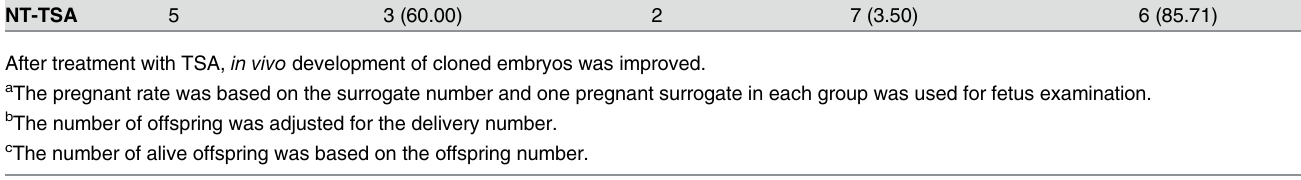
Table 2. In vivo development of cloned embryos treated with TSA. Group